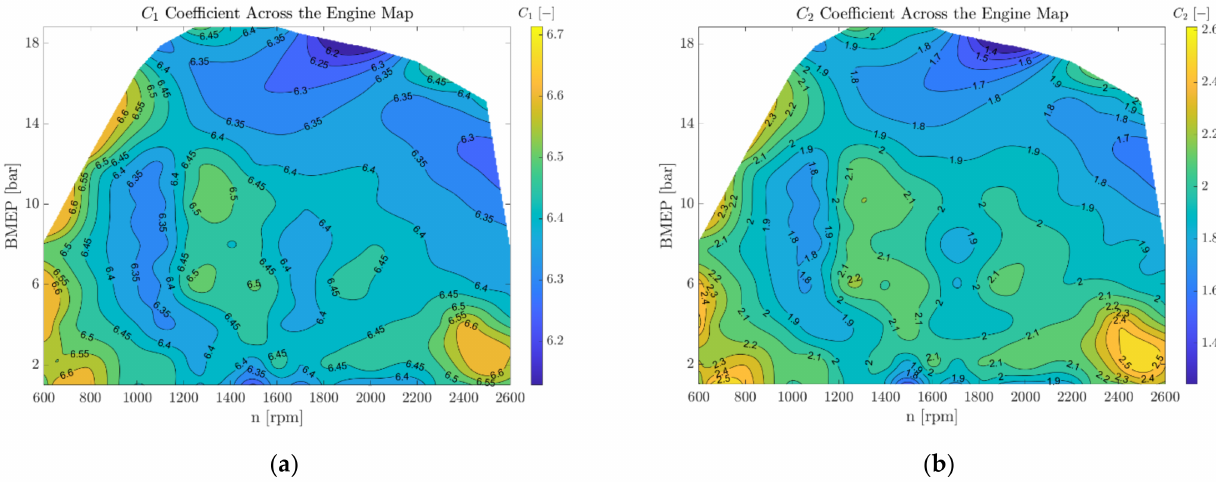
Figure 7. ( a ) C 1 distribution across the engine map; ( b ) C 2 distribution across the engine map. C 1 and C 2 are the coefficients of the classical Woschni heat transfer